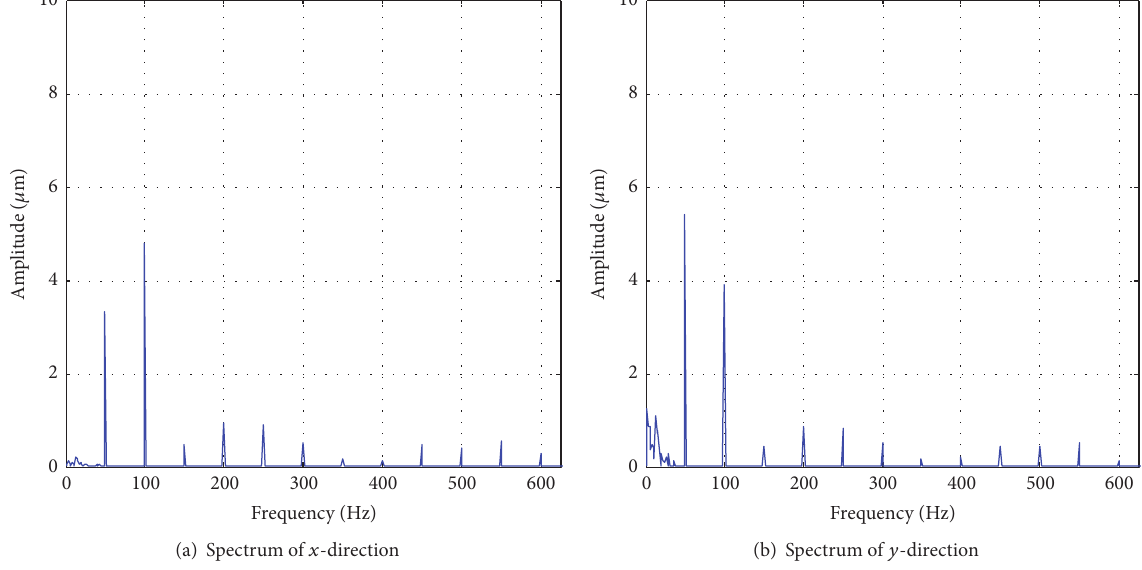
Figure 8: Spectrum of 𝑥 and 𝑦 direction of the same cross